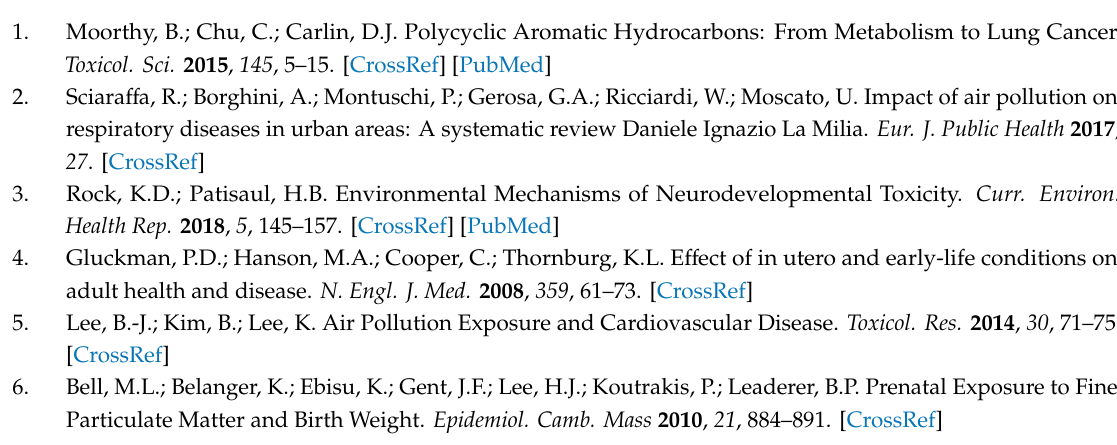
Table S1: List of enhancer